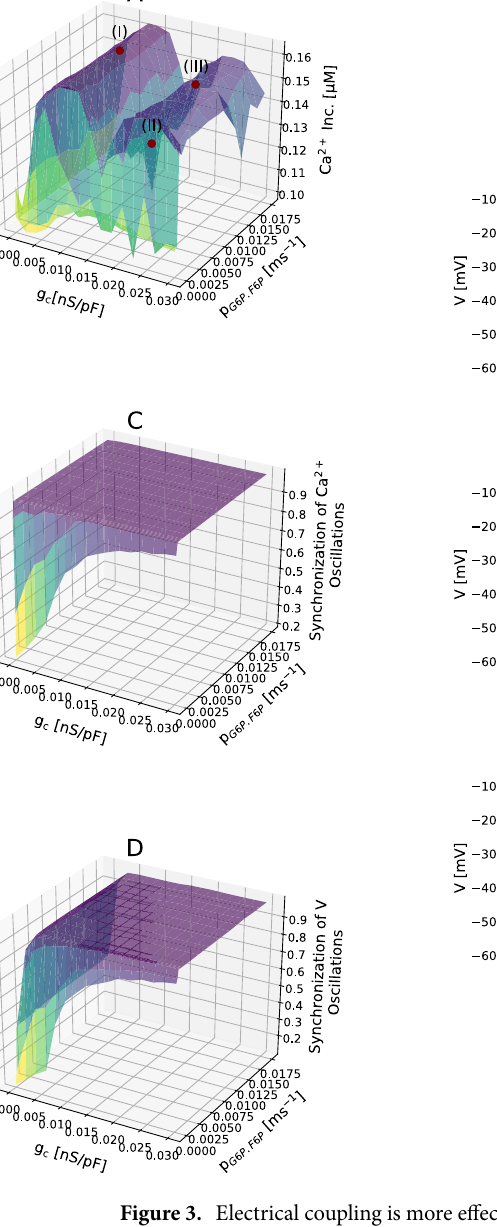
Figure 3. Electrical coupling is more effective on Ca 2 + activity. ( A ) The interplay between electrical coupling and metabolic coupling strength in the mean [ Ca 2 + ] c for all β -cells in a human islet model. Note that gap junction electrical coupling is more effective on intracellular Ca 2 + activity. ( B ) Representative simulated membrane potential and [ Ca 2 + ] c time-courses corresponding to three points (I), (II), and (III) indicated in (A). Changes in electrical behavior cause varying levels of Ca 2 + concentration. ( C , D ) The interplay between electrical coupling and metabolic coupling strength in the synchronization of [ Ca 2 + ] c and membrane potential oscillations. Data in ( A ), ( C ), and ( D ) represent the mean ± S.E.M. over 10 modeled Additionally, we eliminated ∼ 55% the islet β -cells, and then analyzed the role of g c and glucose levels on [ Ca 2 + ] c activity (Fig. 4D–F). As above, intracellular Ca 2 + concentrations of single β -cell and the release of insulin exhibited a steep sigmoidal secretory response to increasing glucose levels. The transition between quiet state and avalanche occurred at a position equivalent to ∼ 5mM glucose, similar to intact islet, while at 5 − 10mM glucose, the slope of [ Ca 2 + ] c elevation was less in islet lacking ∼ 55% β -cells compared with the intact islet, i.e., the level of intracellular Ca 2 + was more slowly saturated. During high glucose concentrations, [ Ca 2 + ] c in islets lacking β -cells was relatively unchanged from the intact islet, although in small values of g c there were notice- able differences (Fig. 4D). Furthermore, when the level of glucose concentrations was elevated, islet synchrony of electrical patterns had complex behavior. In fact, the synchronization of islet lacking ∼ 55% β -cells was less than intact islet and more sensitive to increasing glucose level (Fig. 4E,F).